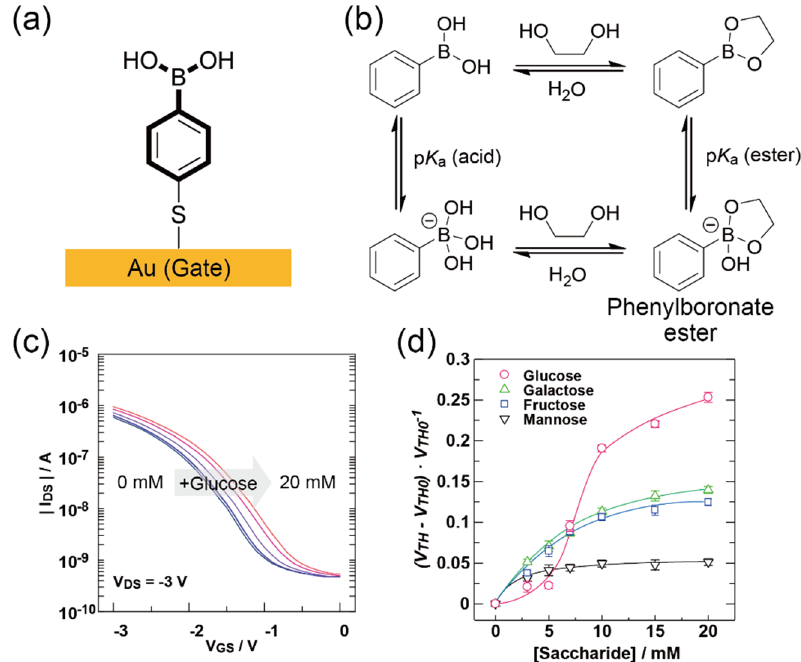
Figure 14. ( a ) Schematic structure of the PBA-SAM. ( b ) Multiple equilibria states involved in the cis-diol exchange with PBA. ( c ) Transfer characteristics of the PBA-modified FET upon the addition of glucose. ( d ) Changes in the output signal of the FET by the saccharides. Reproduced with permission from reference [52]. Copyright 2014 The Royal Society of Chemistry.